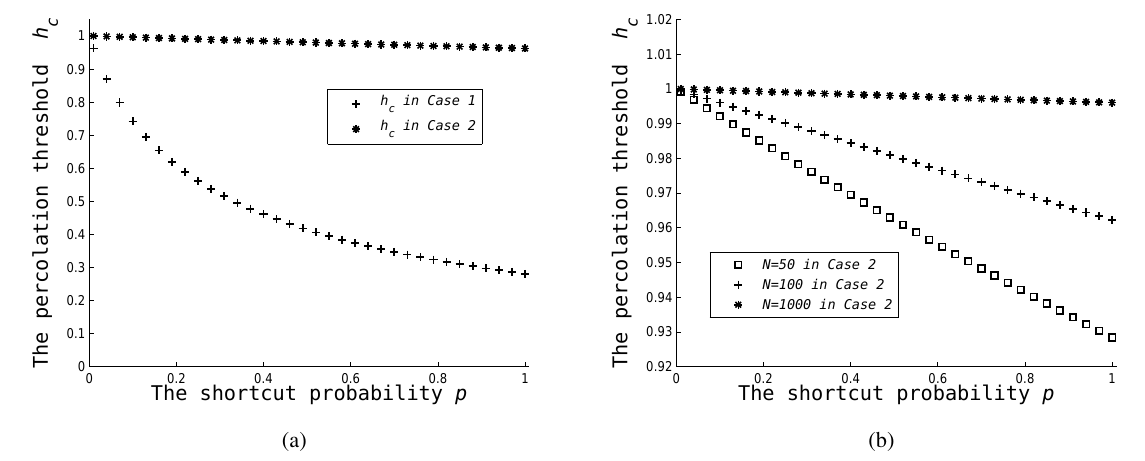
Fig.2. The variety of the percolation threshold h c . Here the lines depict the variety of the percolation threshold h c with the increase of the shortcut probability p in (a) Case 1 and Case 2 ( N = 1000), (b) Case 2 with N = 50, N = 100, and N =